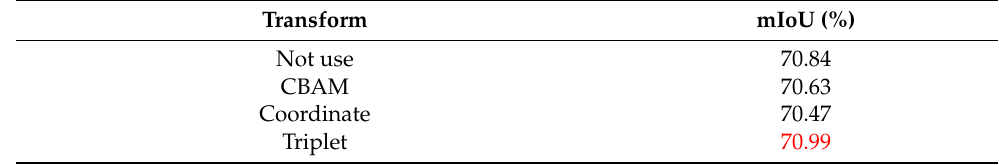
Table 8. Ablation studies of different transform modules. The red color font indicates the optimal